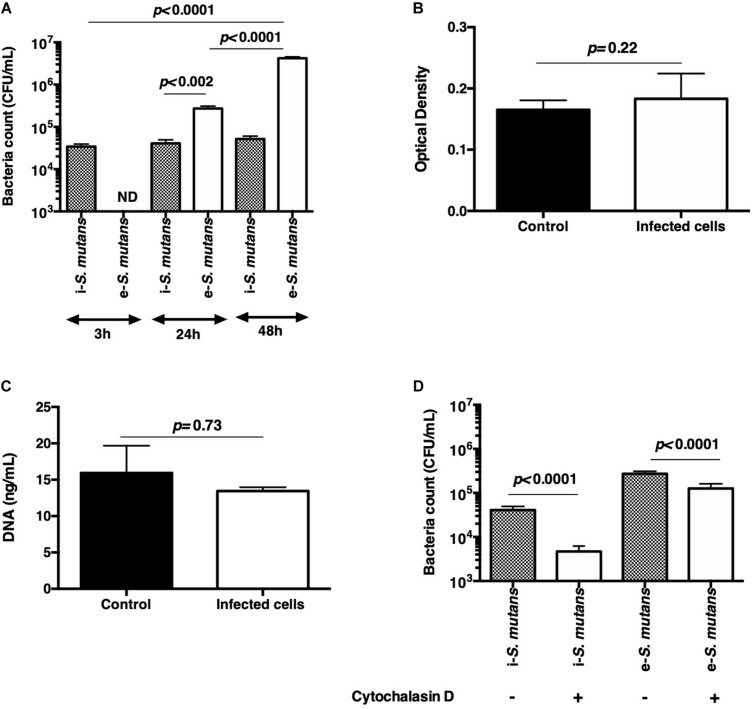
Bacteria persistence. (A) Count of viable intracellular (i-S. mutans) and extracellular (e-S. mutans) bacteria at 3, 24, and 48 h after internalization. Results indicate the absence of intracellular proliferation and the release of S. mutans in the extracellular environment. (B,C) Lactate dehydrogenase cytotoxicity assay and DNA quantification of DPSCs, respectively, indicating the absence of bacteria cytotoxicity after 48 h of culture. (D) Count of viable intracellular and extracellular S. mutans, after 24 h of culture of infected DPSCs in the absence and the presence of cytochalasin D. (Histograms of mean ± SEM, n = 6; Mann & Whitney test; ND = not detected).